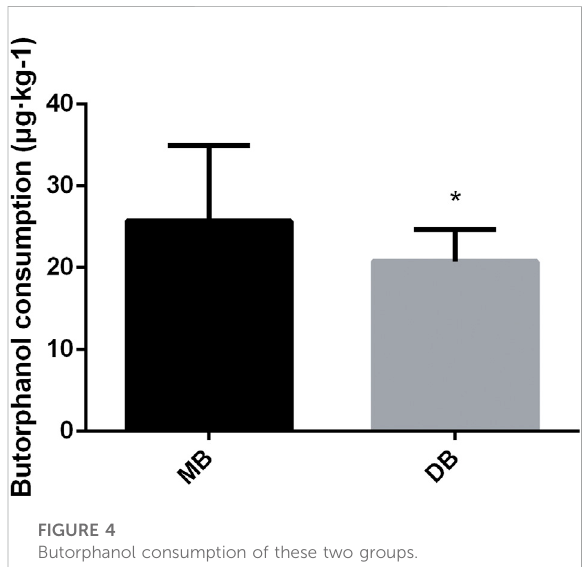
FIGURE 4 Butorphanol consumption of these two